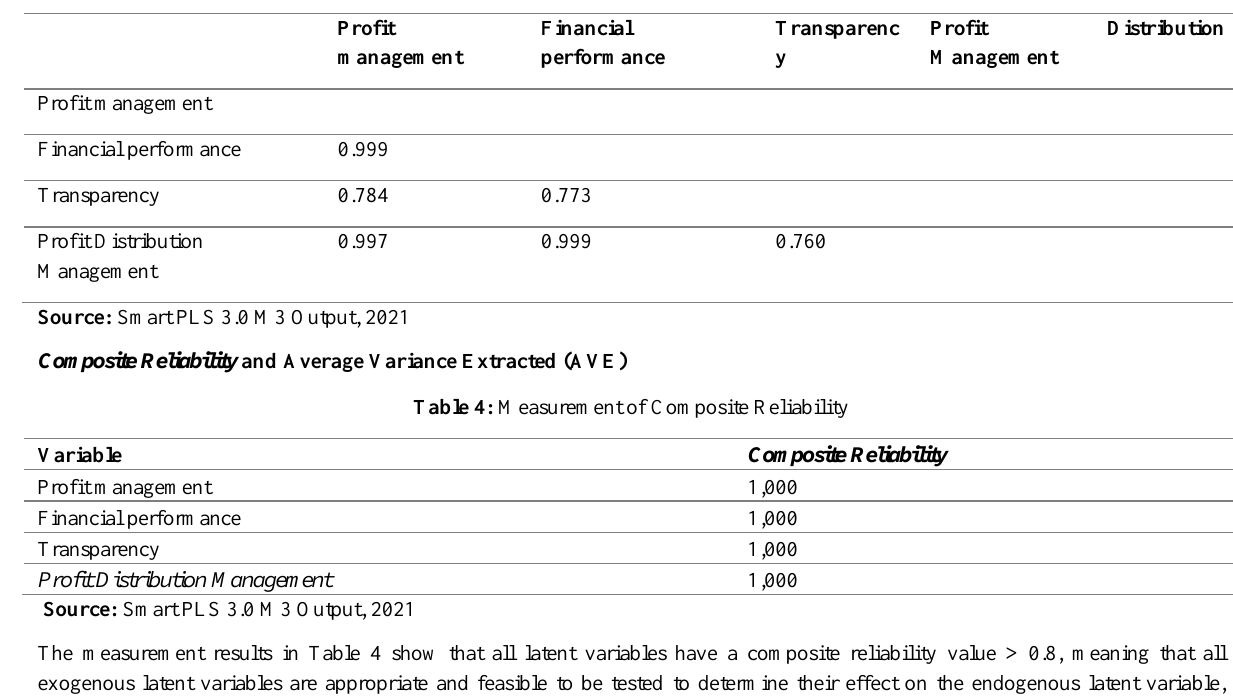
Table 3: Discriminant Validity Value